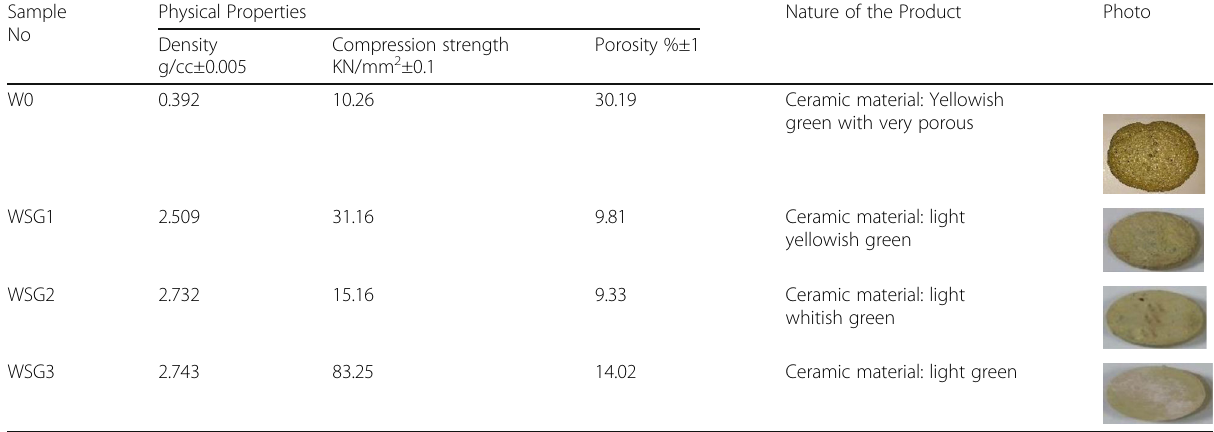
Table 5 Some properties of W0, WSG1, WSG2 and WSG3 samples sintered at 900 °C/2